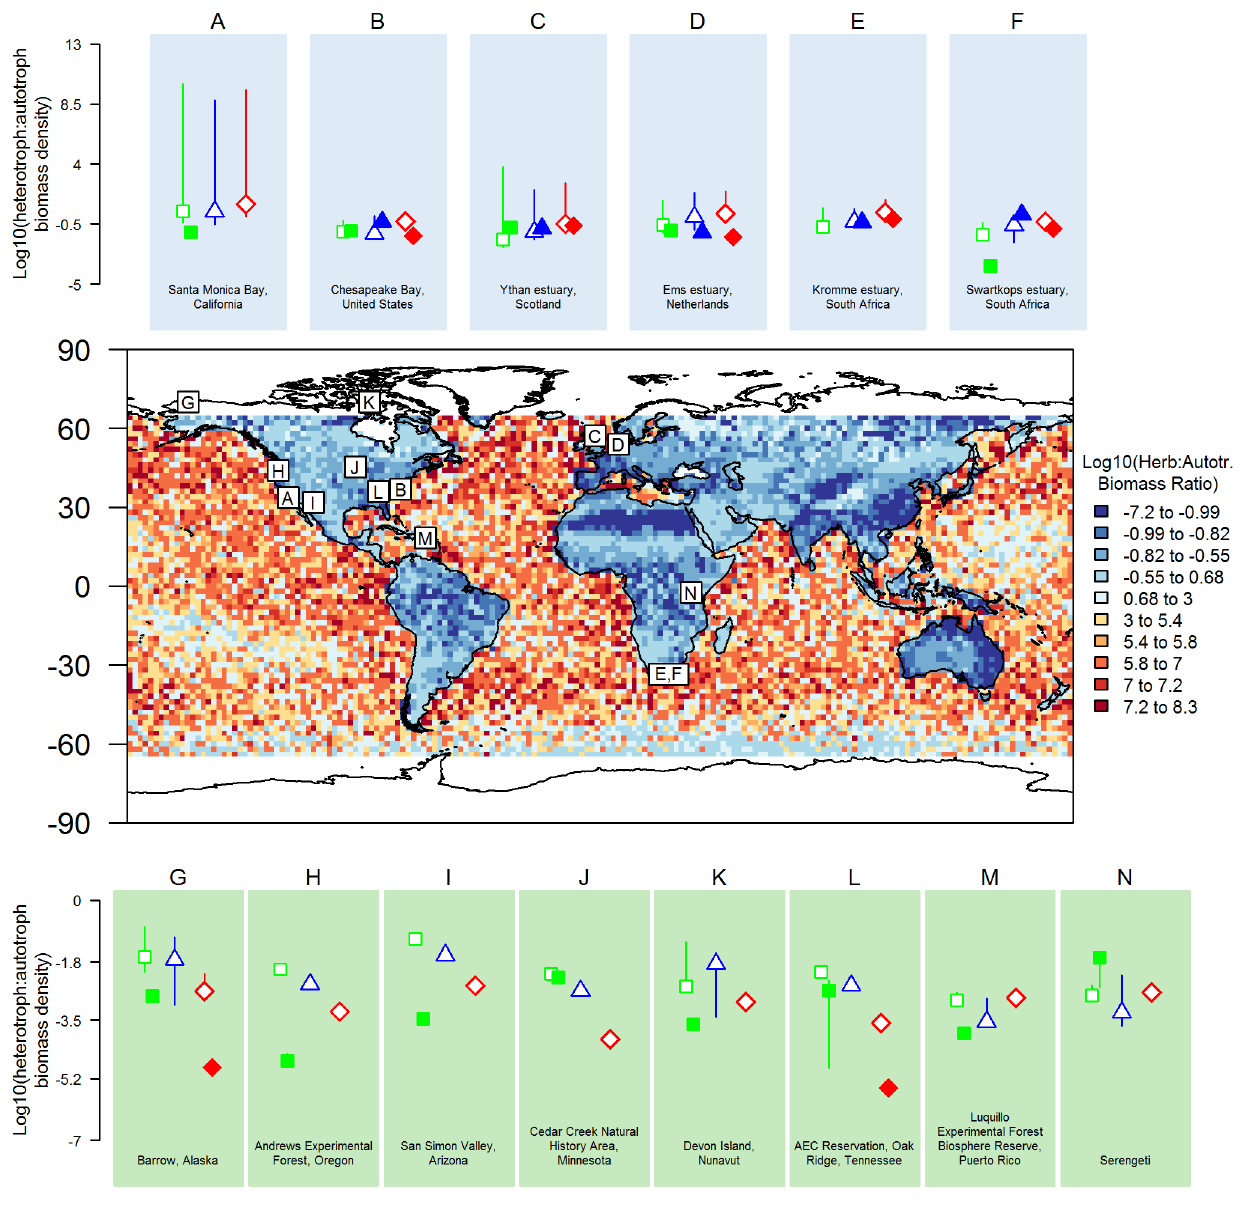
Figure 5. Global heterotroph:autotroph biomass ratios. Comparisons of modelled (open) and empirical (filled) heterotroph to autotroph biomass ratios in marine (A–F) and terrestrial (G–N) environments (Table S3). Green squares are herbivore to autotroph ratios, blue triangles are omnivore to autotroph ratios, and red diamonds are carnivore to autotroph ratios. Modelled ratios are medians from 10 simulations, and vertical lines are 1 standard deviation over these simulations. Empirical ratios are individual estimates or, where more than one estimate was available, the median of these with sample sizes of H ( n =5), K ( n =2), L ( n =2), and N ( n =3), and vertical lines indicate maximum and minimum empirical estimates. Comparison locations are shown on a map of the predicted ratio of herbivore to autotroph biomass constructed from the global simulation (Study 4, Table 3).